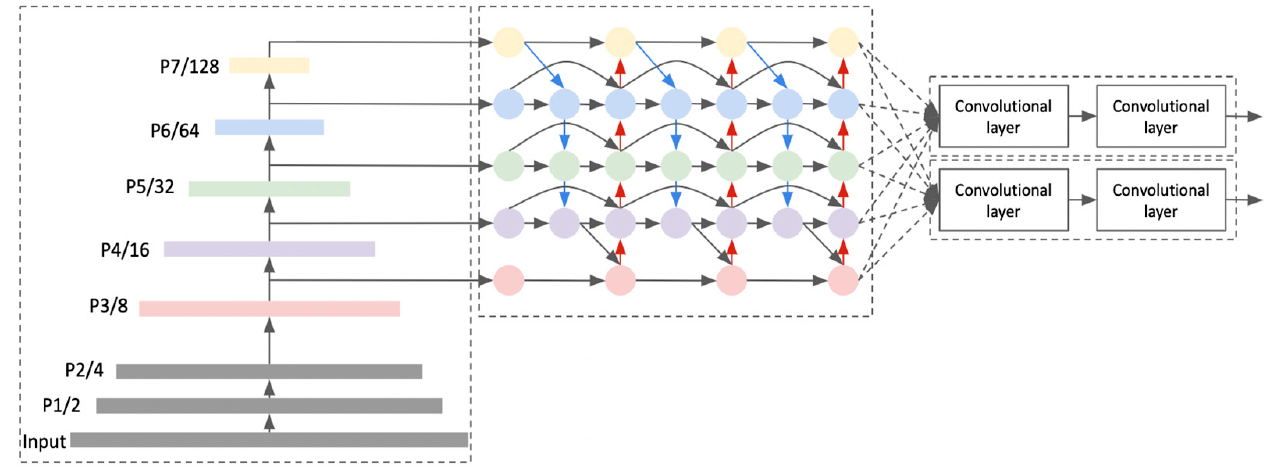
Figure 1. EfficientDet architecture that consists of EfficientNet backbone, BiFPN as feature network neck, and output head.